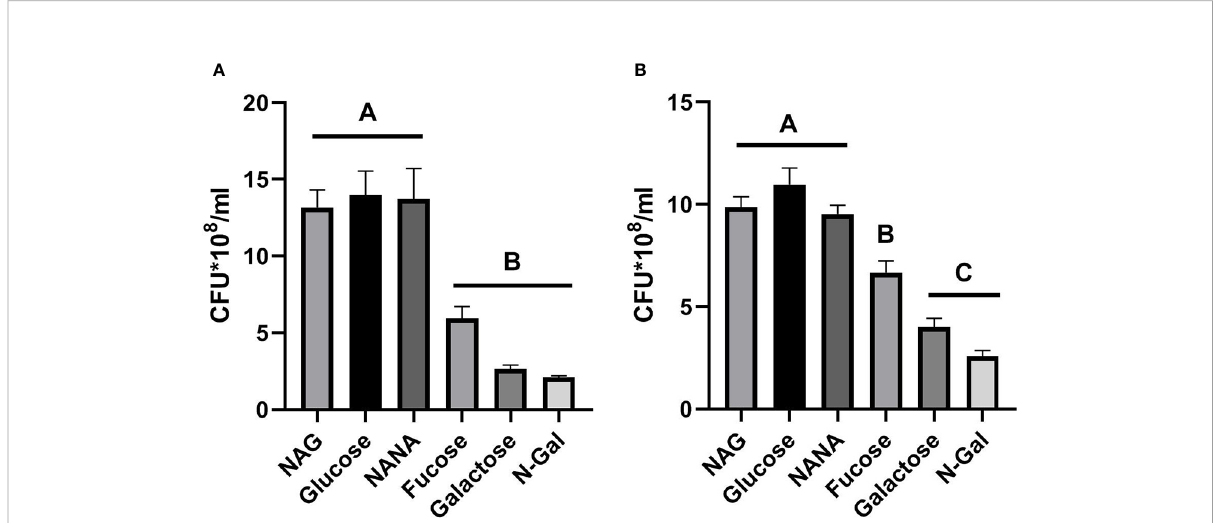
FIGURE 1 E. coli O157:H7 growth in the presence of mucus-derived sugars. E. coli O157:H7 cultures were grown in M9 medium +10 mM mucus-derived metabolites (Fucose, Galactose, N-Gal. NANA or NAG) or Glucose at 37°C for 5 h under agitation in absence of intestinal cells (A) or in the presence of HCT-8 cells monolayers grown on 24-well plates at 37°C in a humidi fi ed 5% CO 2 incubator under static conditions (B) . CFU counting was performed on agar plates and is shown as CFU*10 8 . Data shown as mean ± SEM. Signi fi cant differences were found between groups with different letters (A, B and C) (p<0.05, n=